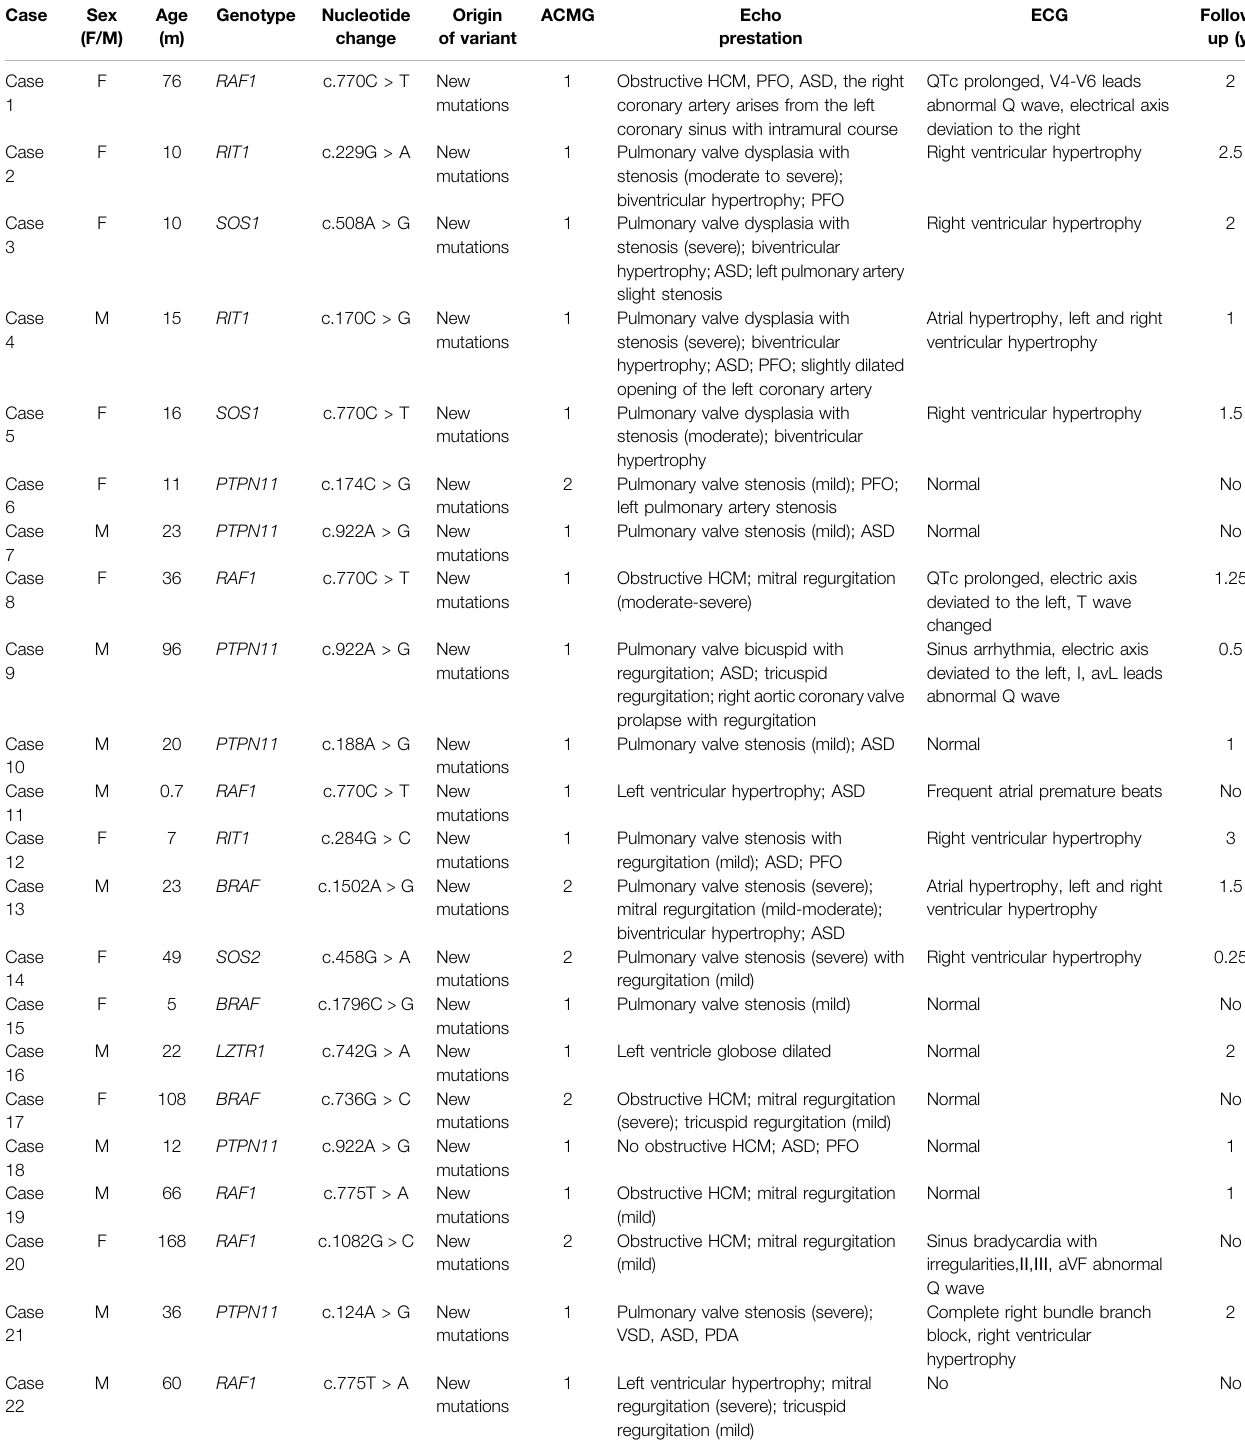
TABLE 1 | NS patients and their clinical